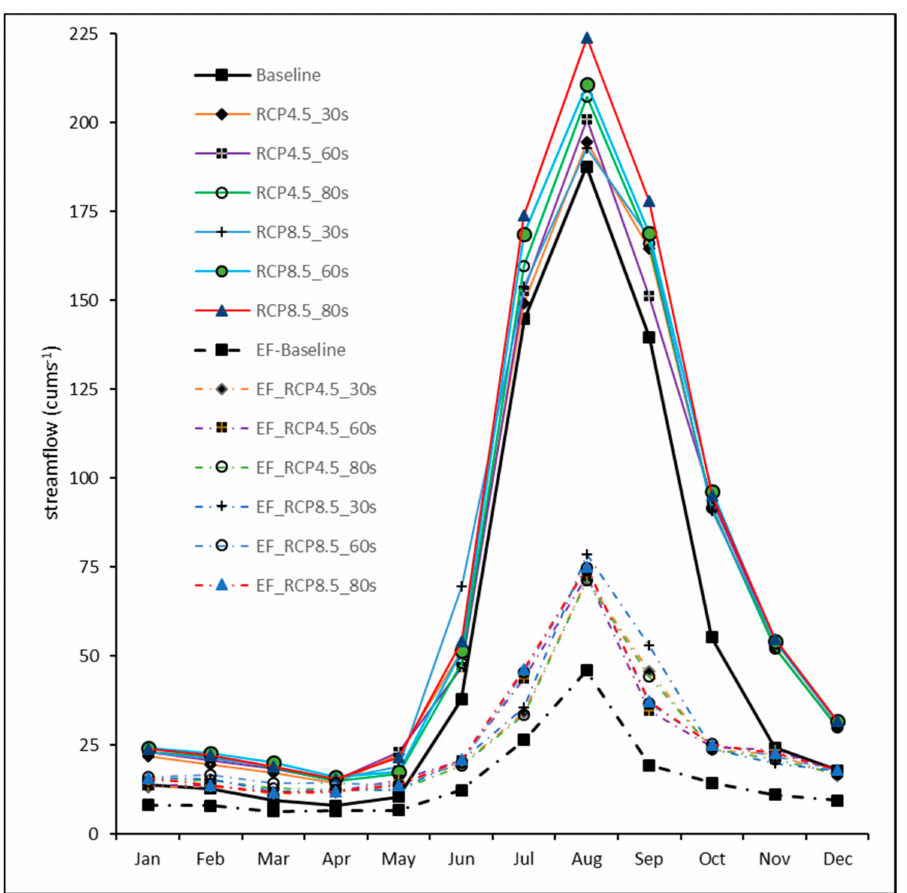
Figure 6. Comparison of monthly mean streamflow between the observed (1991–2014) and the projected values by the ensemble of three GCMs and the corresponding environmental flow under current and future climate